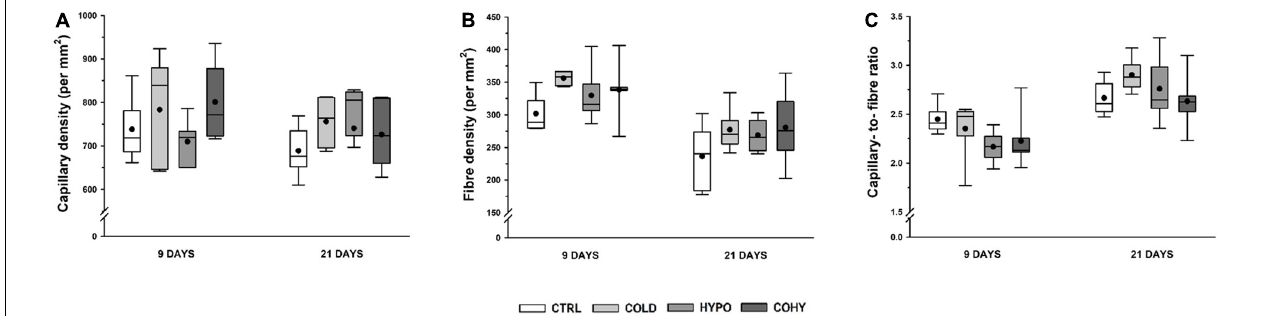
FIGURE 6 | Gastrocnemius global capillarization and morphometric parameters after 9 and 21 days. (A) Capillary density, (B) fiber density, (C) capillary-to-fiber ratio. Sample size: n = 6 per group at each temporal time point.